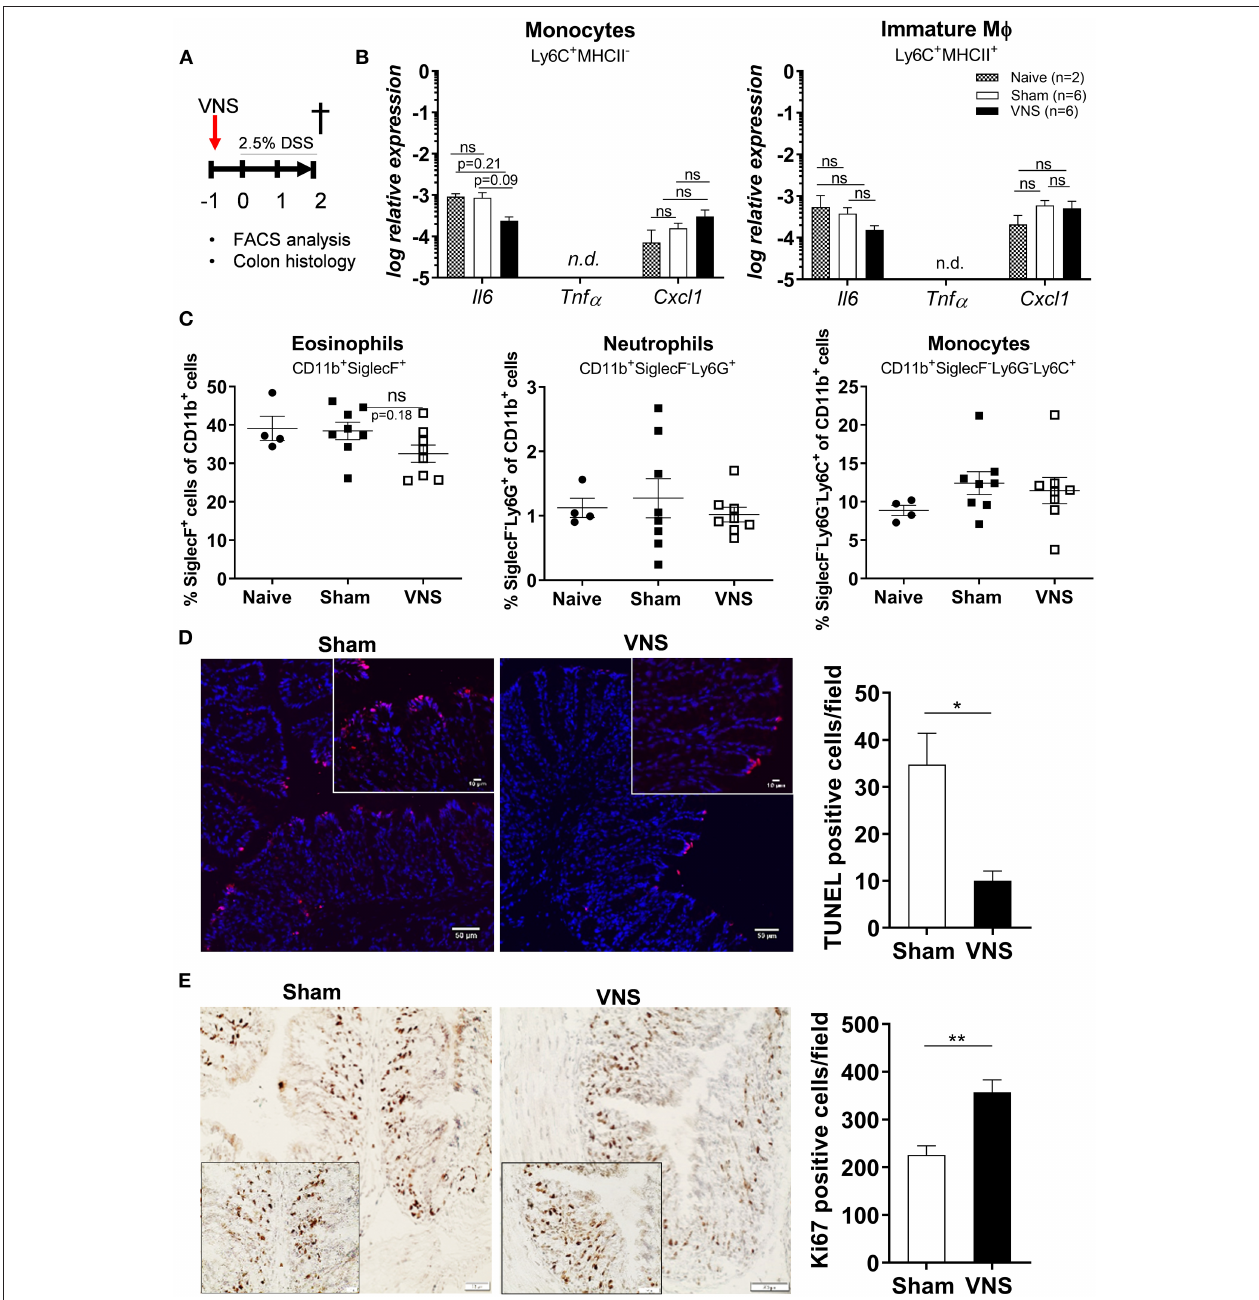
FIGURE 2 | Vagus nerve stimulation tightens the epithelial barrier by reducing apoptosis and promoting proliferation. (A) Wild type mice were stimulated at day − 1 and exposed to 2.5% DSS in the drinking water for 2 days, colitis severity was assessed daily. Mice were sacrificed at day 2 and tissue samples were collected for different analysis. (B) Pro-inflammatory cytokine and chemokine expression was quantified in sorted colonic monocytes and immature macrophages (M ϕ ) isolated from sham and VNS-treated mice at day 2. Data are expressed as mean ± SEM as determined by one-way ANOVA with multiple testing. * p < 0.05; ns, not significant; n.d., not detected; (naïve mice n = 2; sham-operated mice n = 6; VNS-treated mice n = 6). (C) Percentage of eosinophils, neutrophils, monocytes and CD169 + M ϕ in lamina propria of sham and VNS-treated mice at day 2. Data are expressed as mean ± SEM as determined by the one-way ANOVA with multiple testing. ** p < 0.01 (naïve mice n = 4; sham-operated mice n = 8; VNS-treated mice n = 8). (D,E) Representative images of colonic sections stained for TUNEL (D) and Ki67 (E) from sham- and VNS-stimulated mice and their relative cell count. Scale bars are 50 µ m and the scale bar of the inlet is 10 µ m. Bar graphs represent TUNEL-positive cells/field (D) and Ki67-positive cells/field (E) of sham- and VNS-treated mice 2 days post colitis induction. (D,E) Data are expressed as mean ± SEM as determined by the unpaired t -test ( n = 5–6 mice per group).